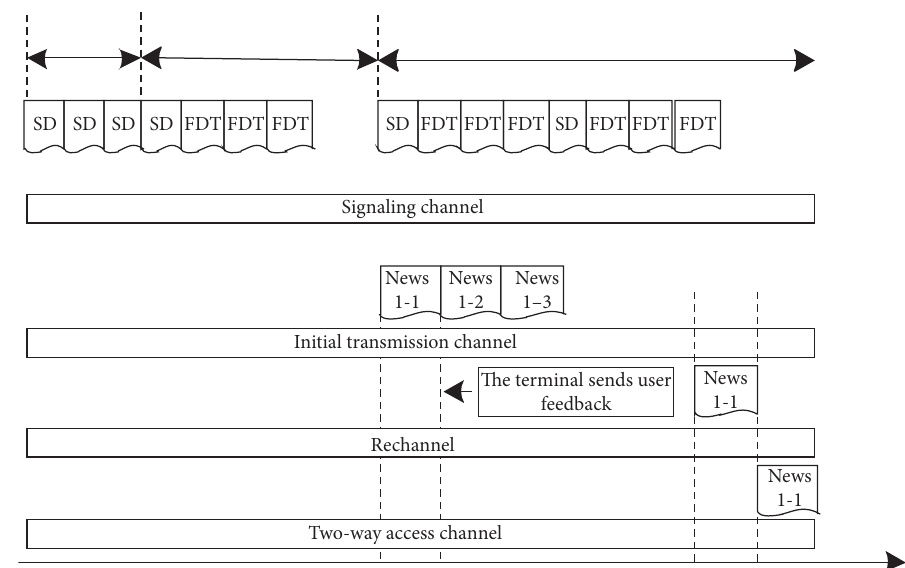
Figure 5: Schematic diagram of push server channel